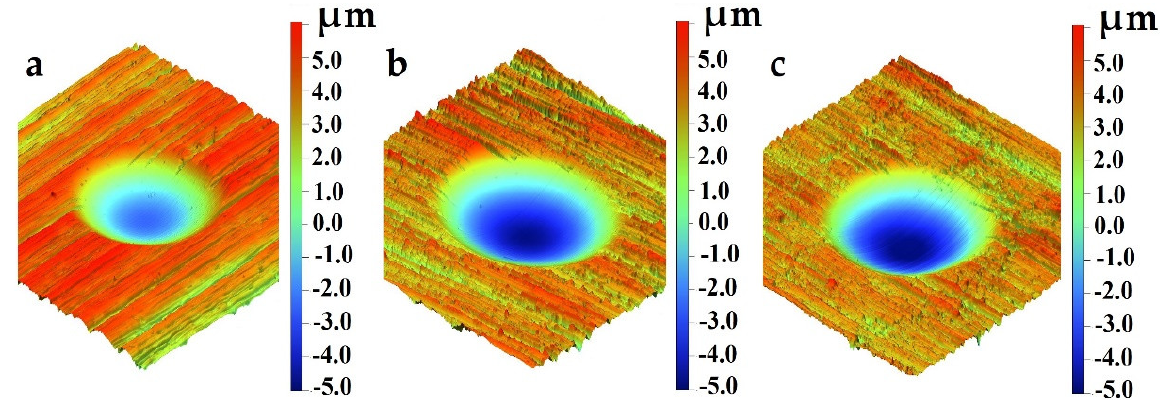
Figure 15. The development of destructive processes in the contact area during abrasive wear tests.